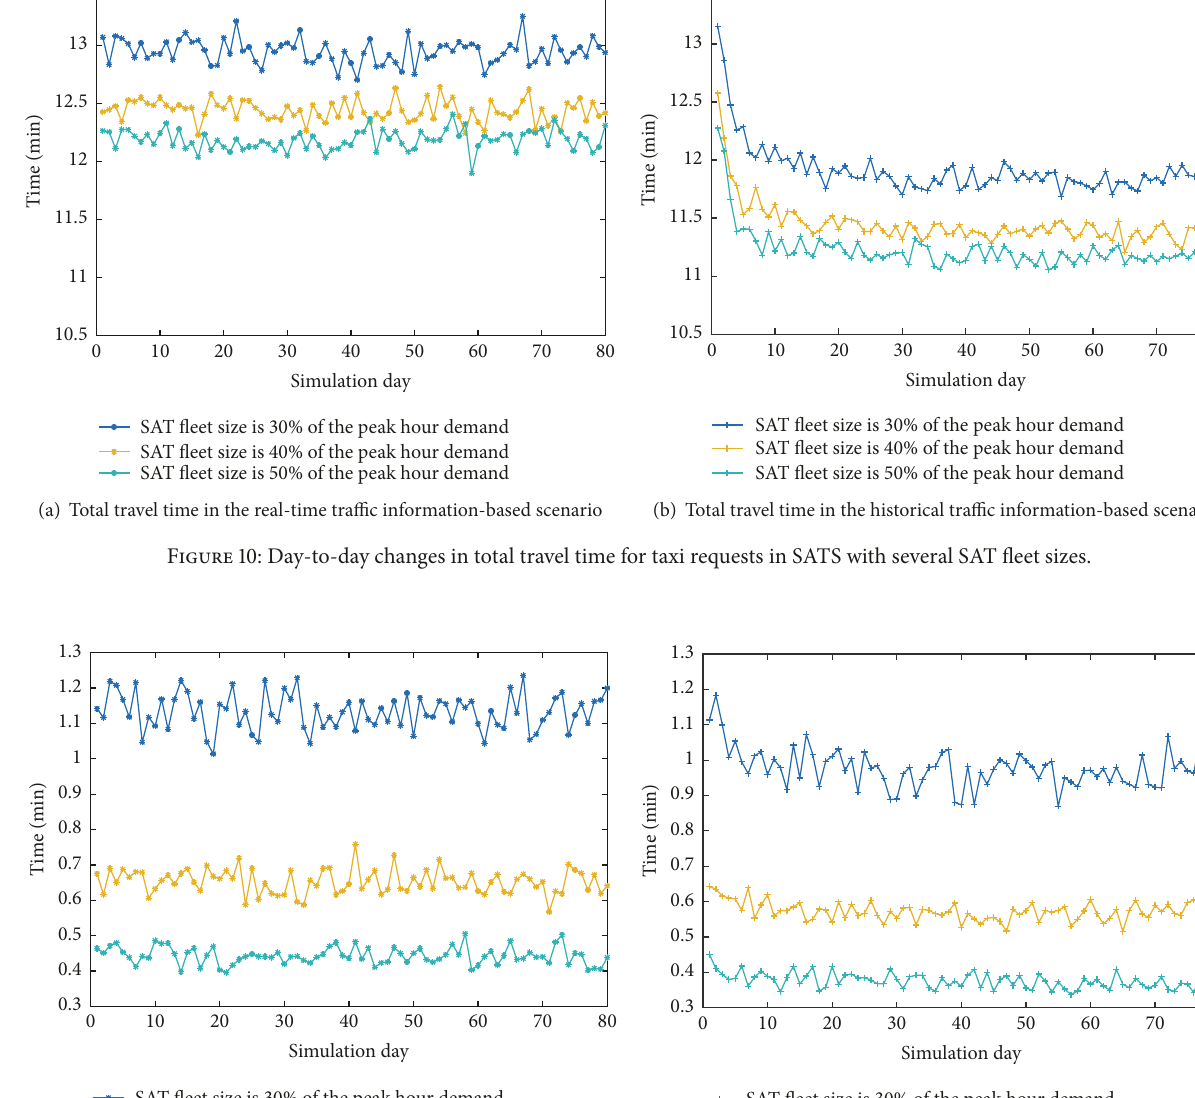
SAT fleet size is 30% of the peak hour demand SAT fleet size is 40% of the peak hour demand SAT fleet size is 50% of the peak hour demand